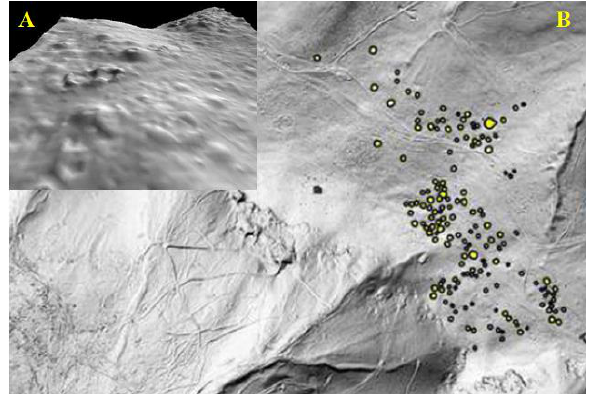
Figure 1. Burial place detection in 3D (A) and 2D (B)